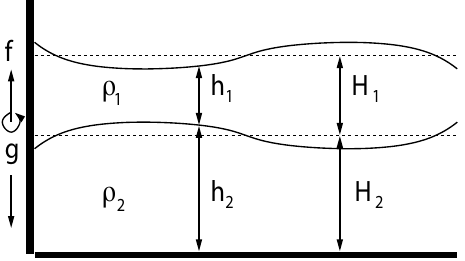
Fig. 1. A side view of the two-layer rotating shallow water model with a straight coast on the f plane.